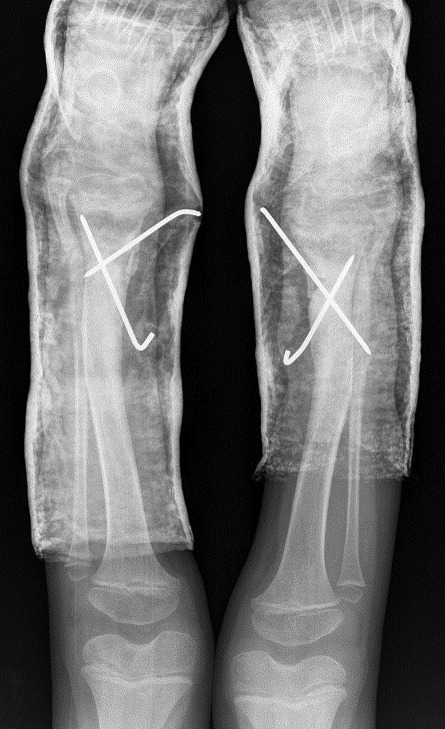
Posoperative Rx.